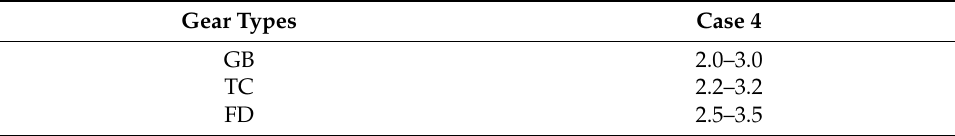
Table 7. Lower and upper ranges of Case 4